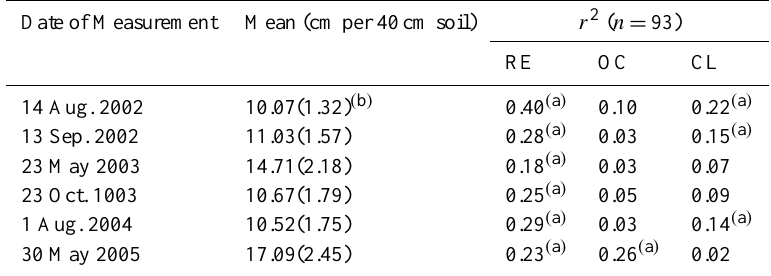
Table 1. Mean and standard deviation of soil water storage at the Alvena site during six observation dates and relationships to relative elevations (RE), organic carbon (OC), and clay content (CL).